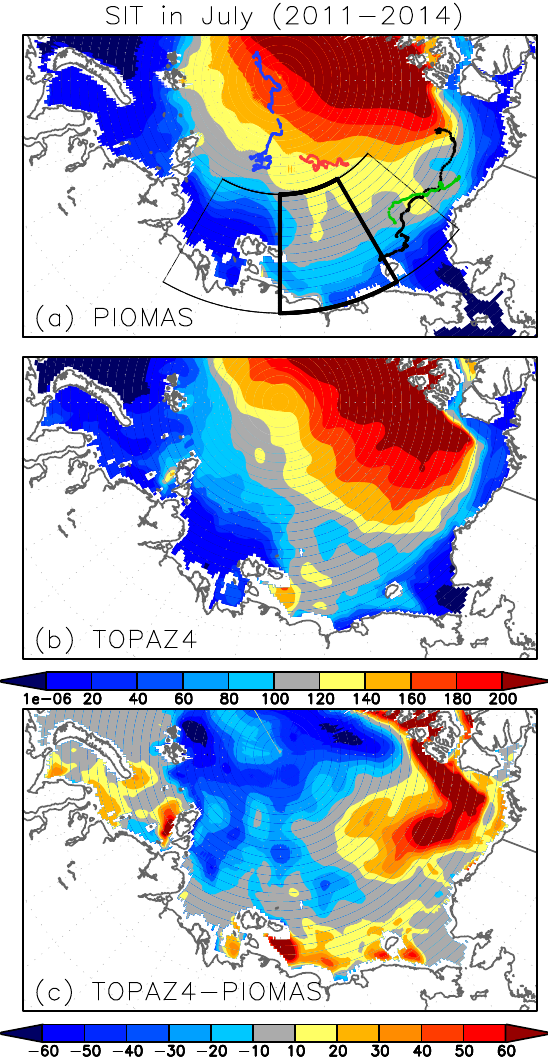
Figure 1. Spatial distribution of climatological monthly mean of SIT (centimetres) in July during 2011–2014: (a) PIOMAS, (b) TOPAZ4 reanalysis and (c) their difference (centimetres). The boundaries of the ESS and Arctic marginal seas are indicated in panel (a) by thick and thin lines. In panel (a) , the trajectories of IMB buoys for 2011K, 2012I, 2012J and 2014B (see Table 1 for the details of each buoy data) are shown by black, red, blue and green